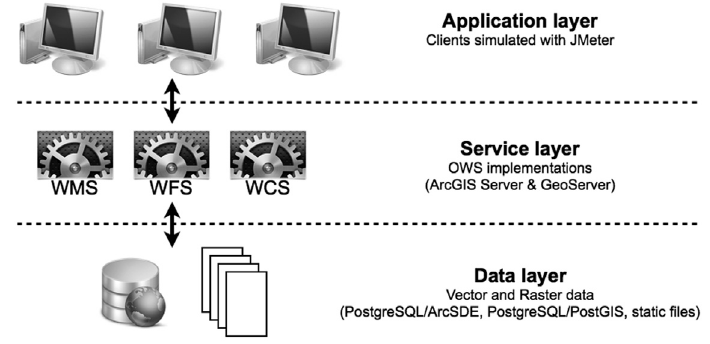
Figure 1: Architecture used for testing different OWS